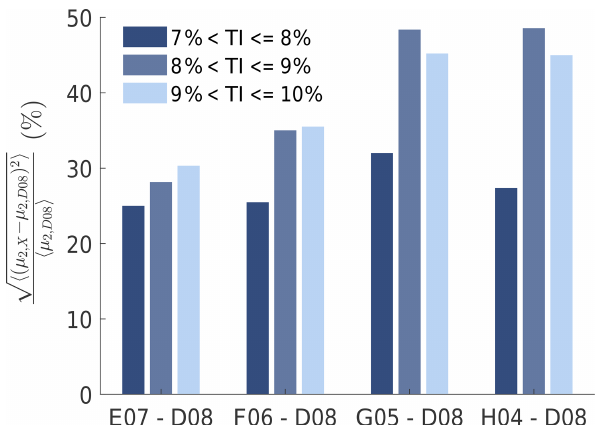
Figure 3. Effect of separation distance and atmospheric stability on variance of the second-order moment of nacelle wind speed be- tween the western front-row turbines of Lillgrund wind farm. At- mospheric stability is implicitly characterized using turbulence in-